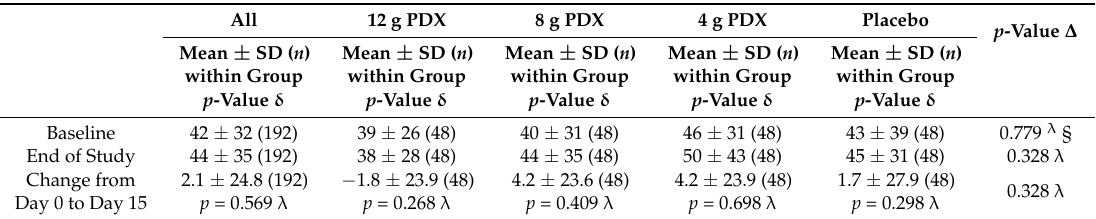
Table 3. Total colonic transit time results at baseline (Day 0) and end of study (Day 15) for participants in the intention-to-treat population ( n =